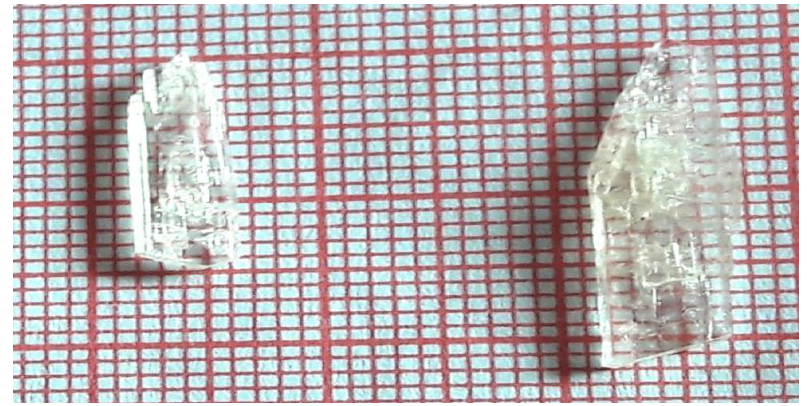
Figure 1. The photograph of LPPMA.